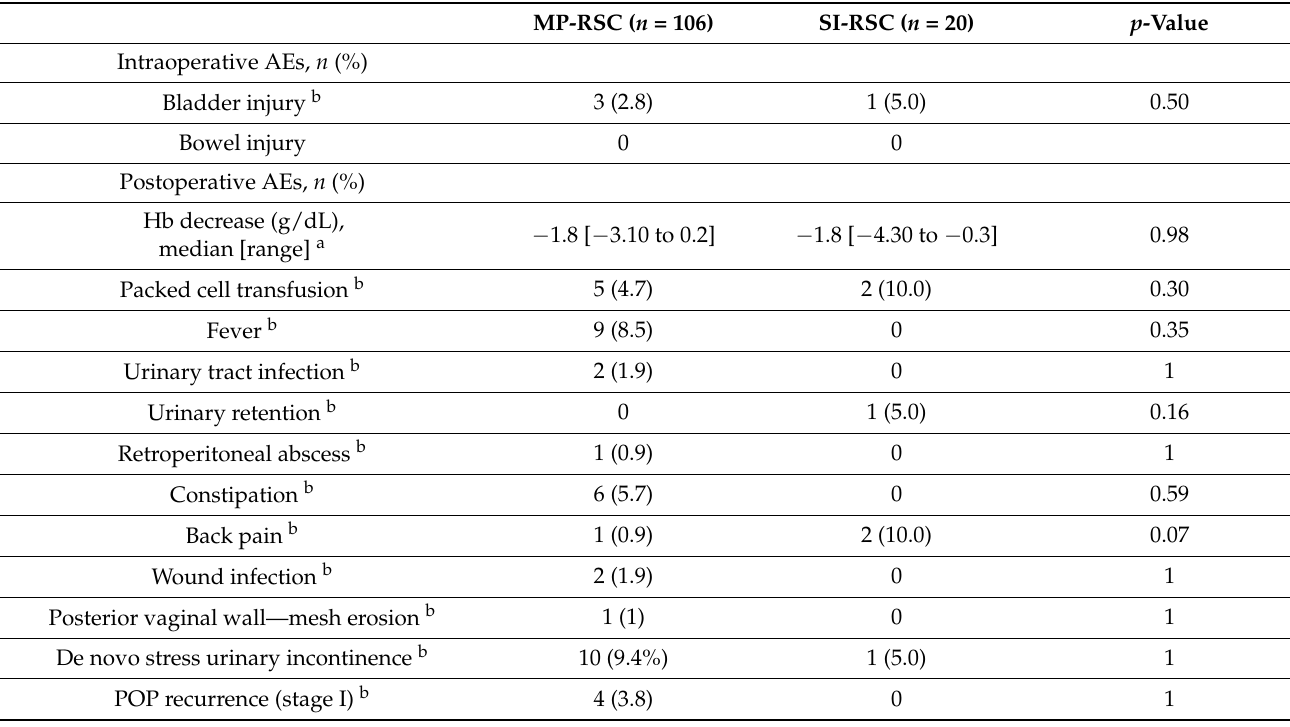
Table 4. Comparison of intraoperative and postoperative adverse